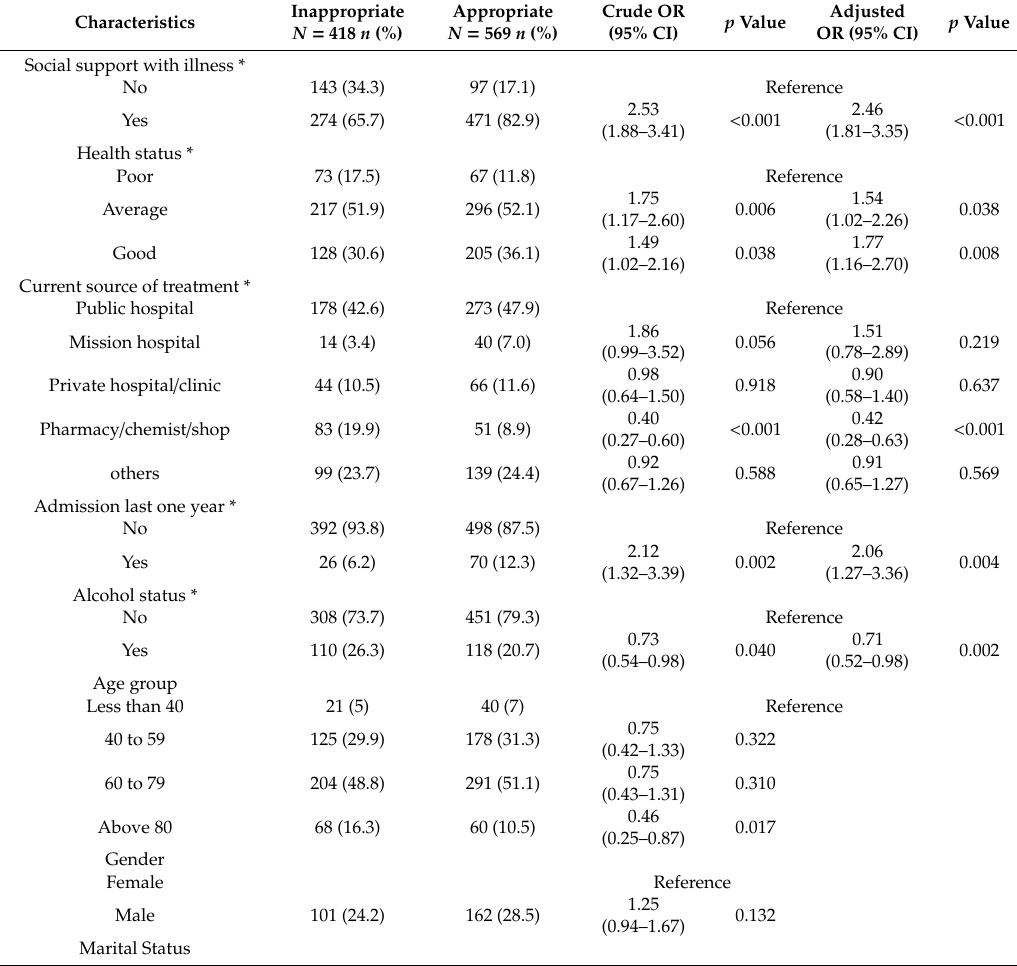
Factors associated with health-seeking behaviour among respondents with diabetes and / or